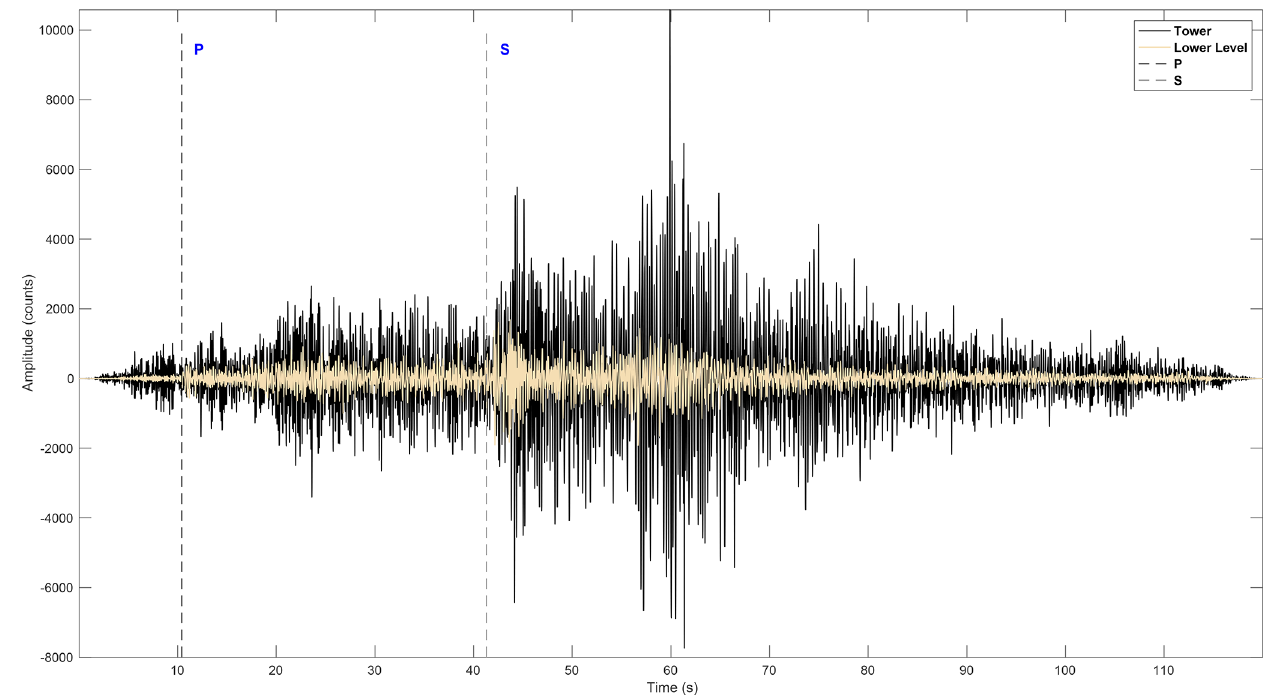
Figure 11. Seismic signals from the Lincolnshire earthquake recorded on one of the seismometers on the first floor of the WMB (beige) overprinted on a waveform of the same event recorded at station GT01 (black) in the WMB tower. The signal from the tower is more than double the amplitude of that recorded on the first floor of the building. Both traces were bandpass filtered between 2 and